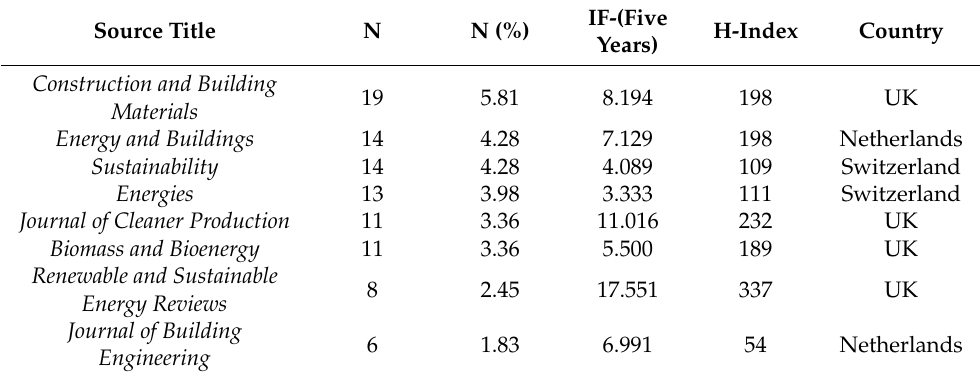
Table 2. Top 8 journals by number of